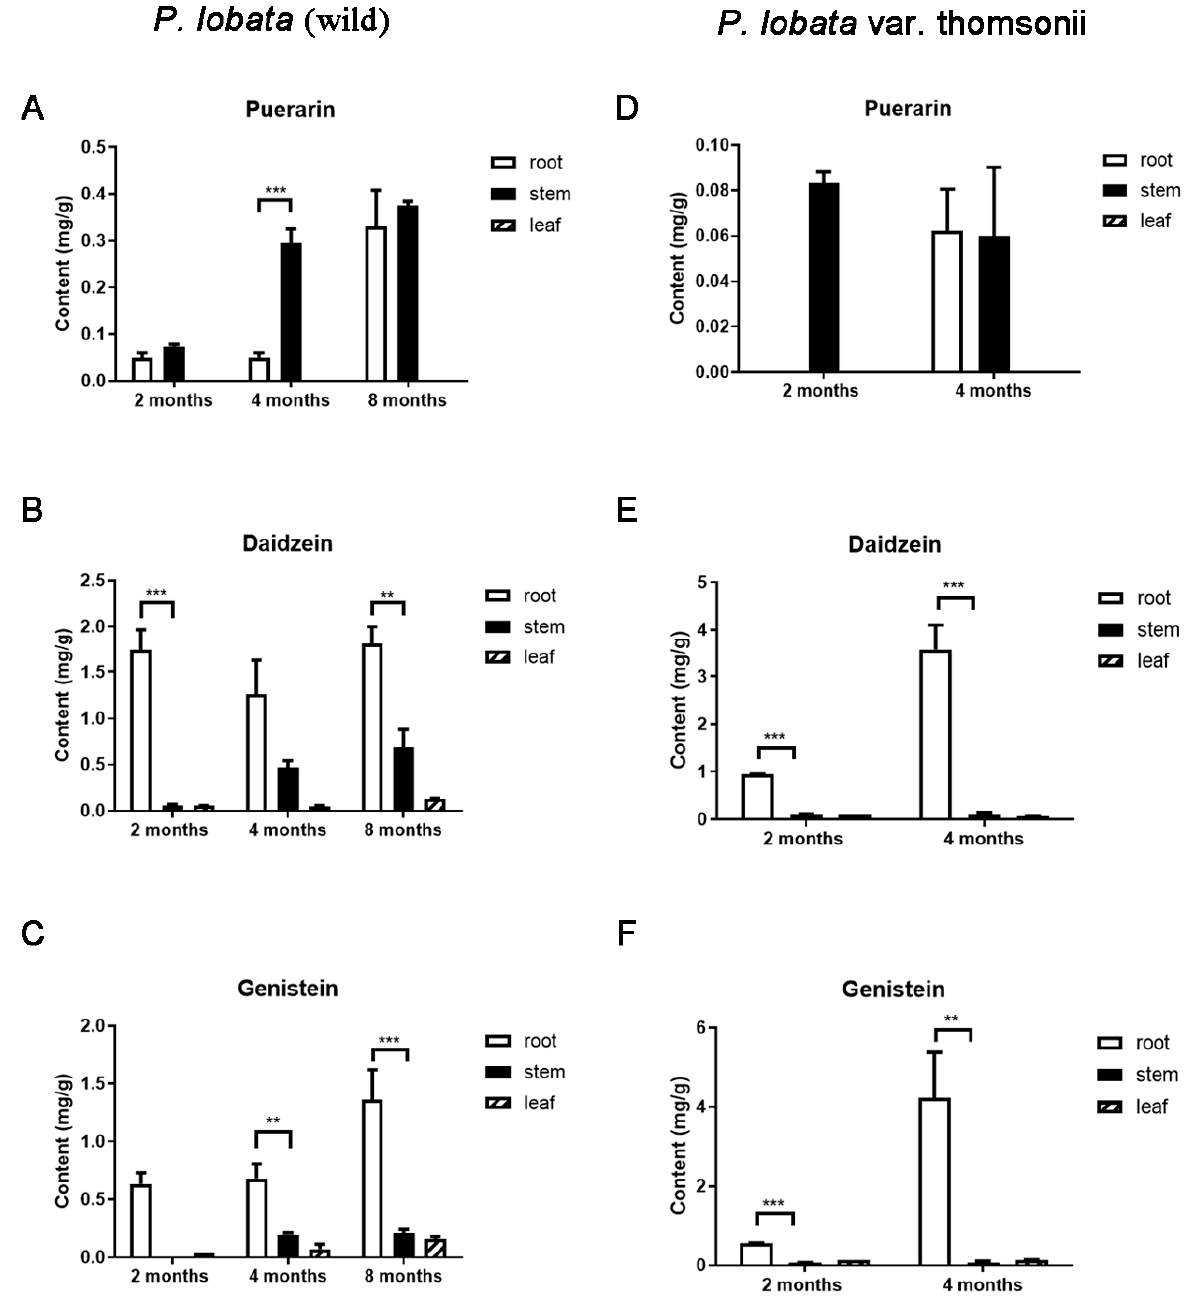
Figure 2. Comparison of the levels of genistein, daidzein, and puerarin in different tissues at different growth stages of P. lobata (wild) and P. lobata var. thomsonii. Data are shown as the average with standard errors of three biological replicates at each growth stage. Asterisks indicate statistically significant differences between roots and stems (** p < 0.05; *** p < 0.01).